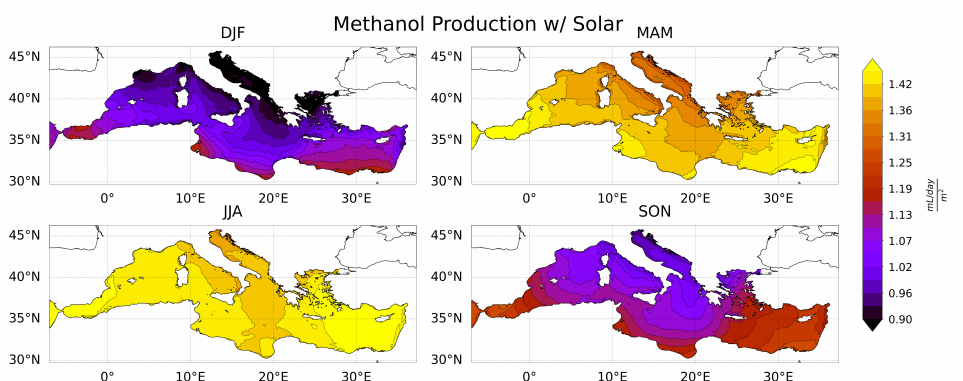
Figure 17. Methanol production powered by the solar panel power shown in Figure 11. Note the values are in milliliters per day per area.